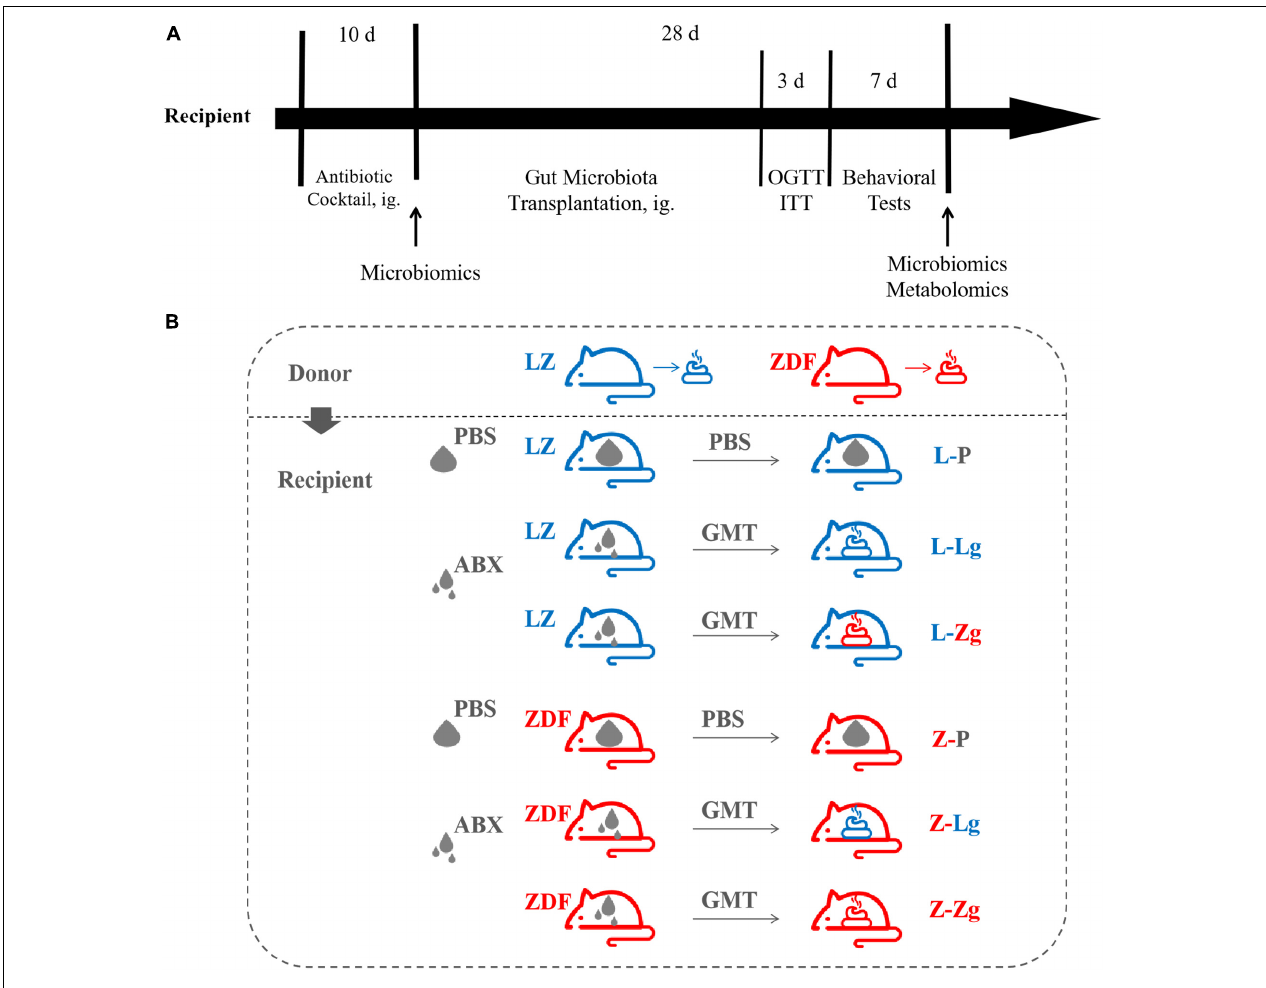
FIGURE 1 | Experimental design of gut microbiota transplantation (GMT). (A) Timeline of experiment. (B) Different treatment groups of